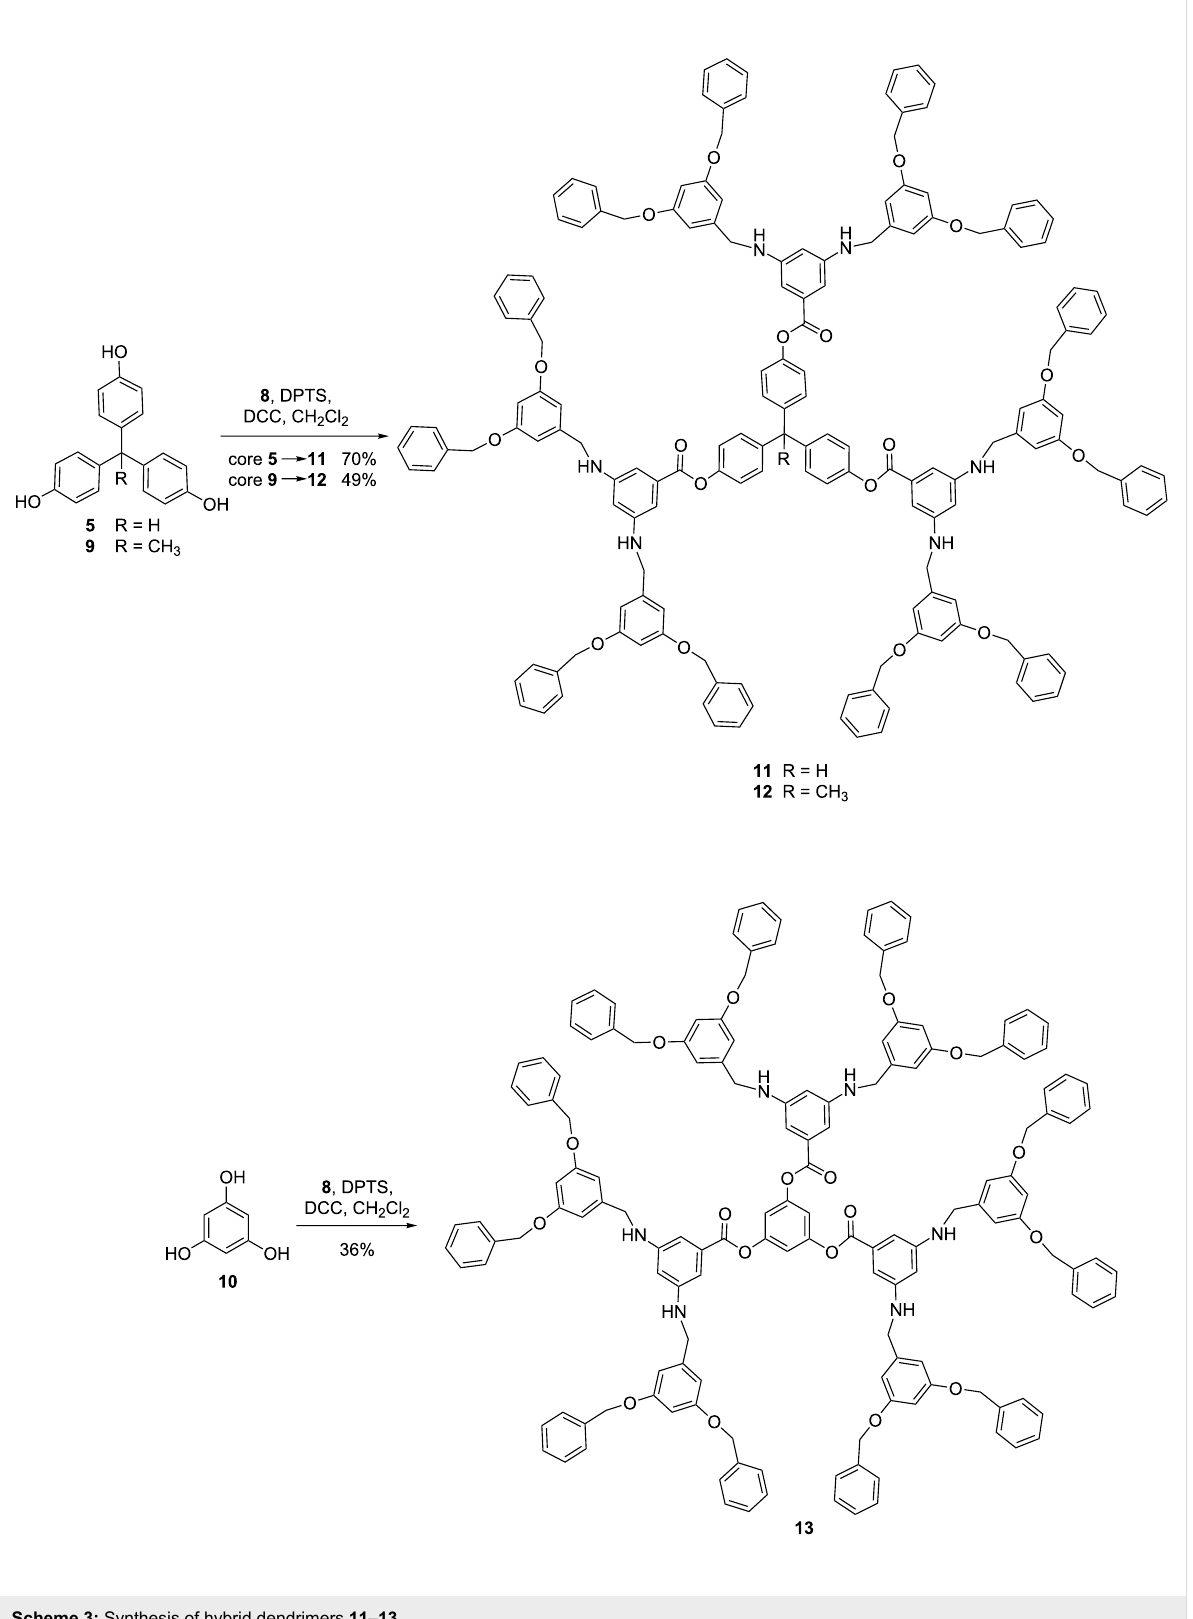
Scheme 3: Synthesis of hybrid dendrimers 11 – 13